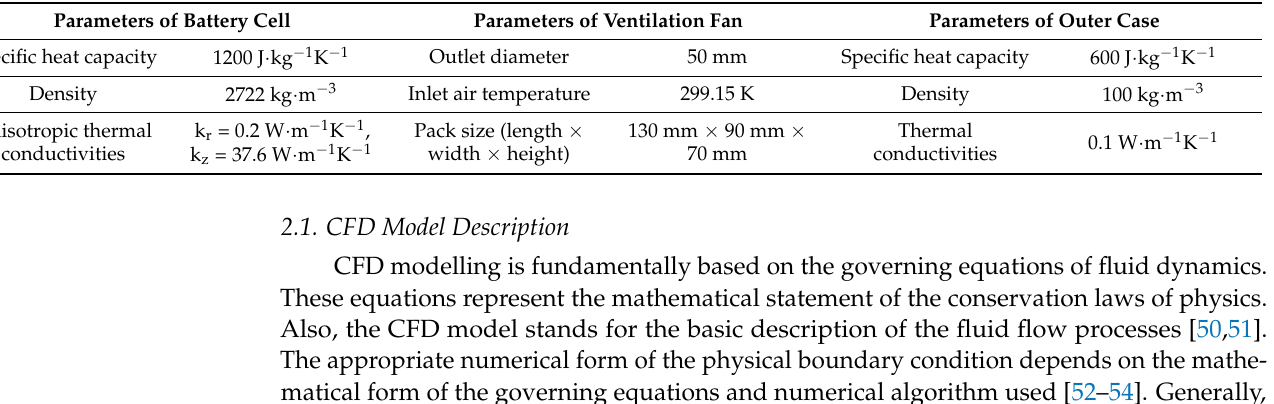
Table 1. Parameters and properties of the battery cell, ventilation fan and outer